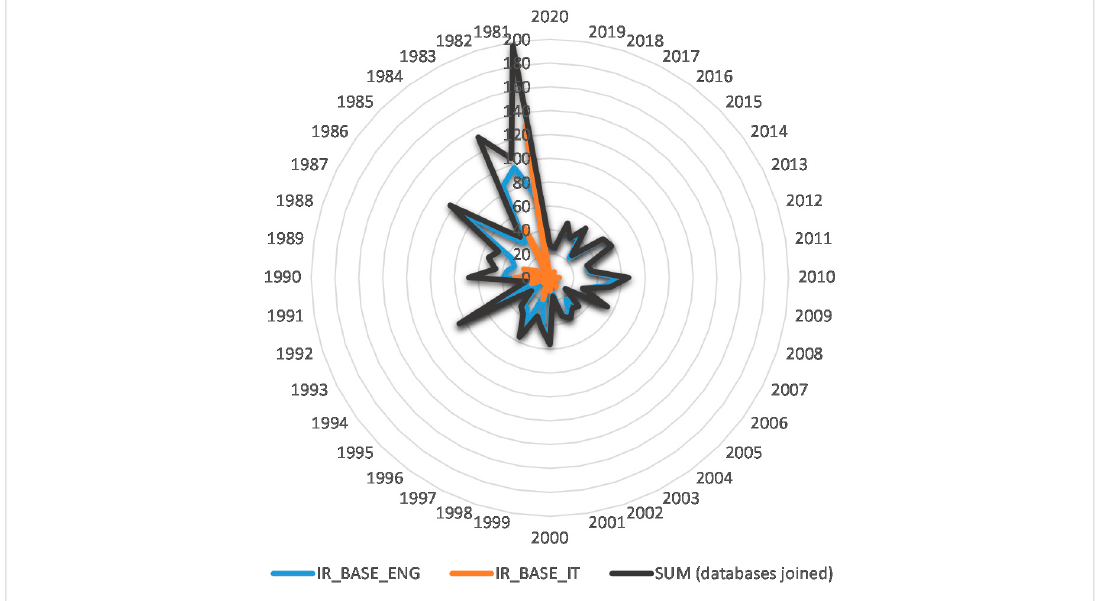
Figure 4. Number of authors involved in the research on 1980 since the earthquake occurrence. The data are represented both for each database taken individually and through the sum of the data contained therein. In the counting, the works published as “Working Group” are considered as published by one author.